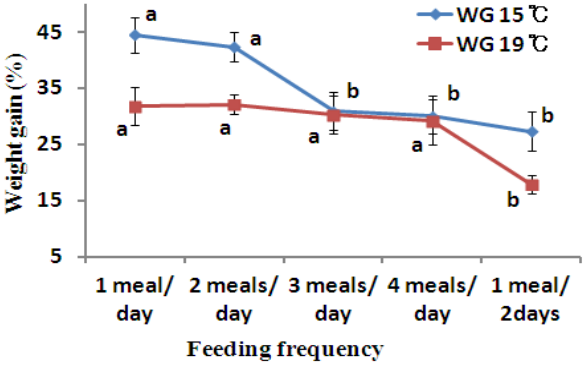
Figure 1. Weight gain of rockfish with different feeding frequencies at 15°C and 19°C.